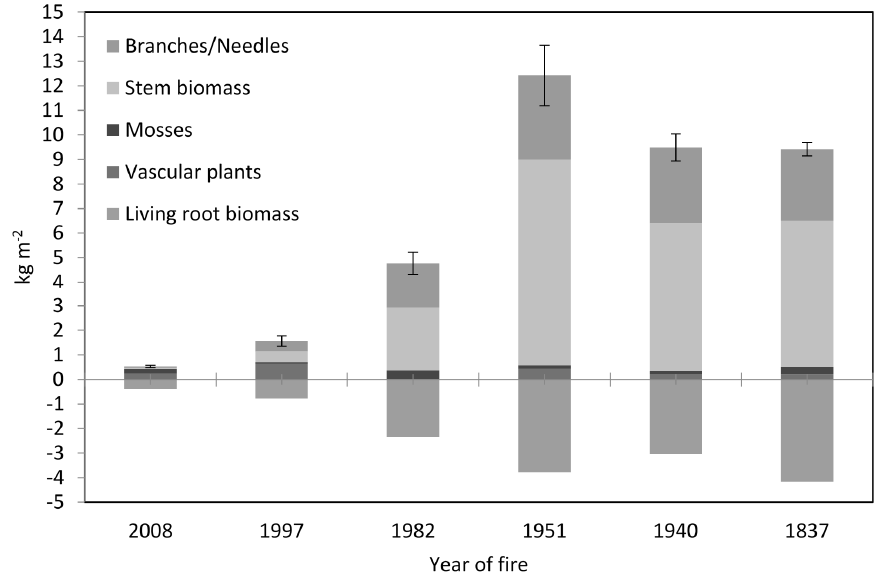
Figure 2. Average aboveground (branches/needles, tree stems, mosses and vascular plants) and belowground biomass (kg·m − 2 ) in a fire chronosequence.